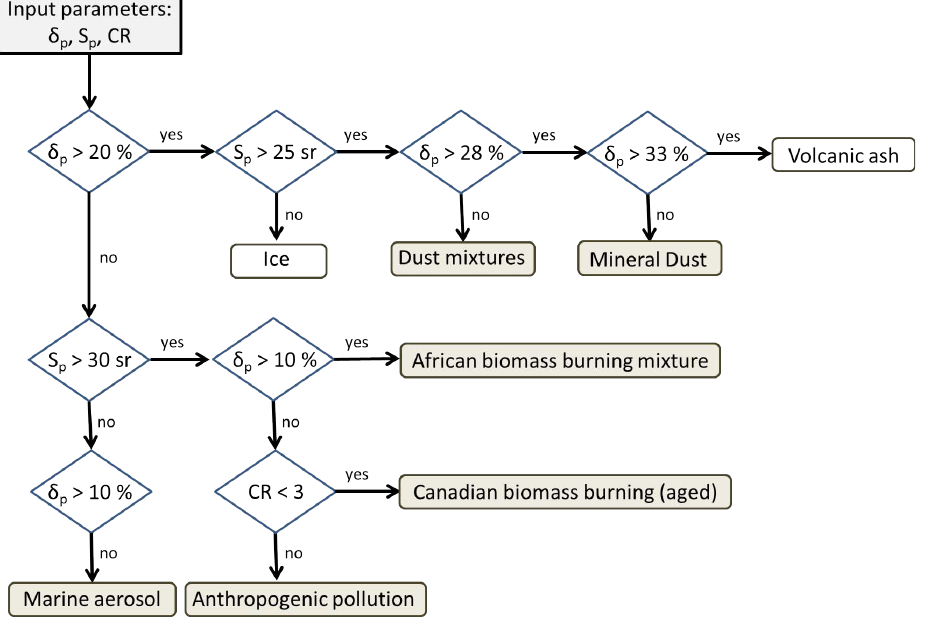
Fig. 8. Flowchart of the aerosol type classification based on three intensive lidar derived optical properties. Grey shaded aerosol types represent aerosol types characterized by DLR HSRL measurements, white shaded aerosol types are defined from literature information.